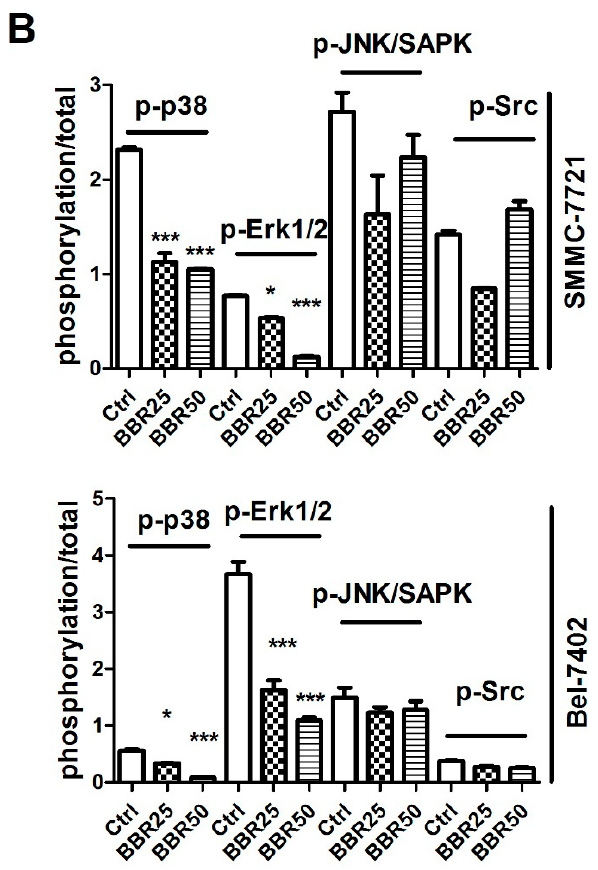
Figure 6. Inactivation of p38 and Erk1/2 in the low concentration of BBR-treated HCC cells by western blot. SMMC-7721 and Bel-7402 cells were treated with BBR for 6 h. Proteins were collected, determined and expression of p-p38, p-Erk1/2, p-JNK/SAPK and p-Src were analyzed by western blot. The expression of total proteins was used as internal standard. ( A ) Protein expression was observed by ChemiDoc™ XRS + Molecular Imager; ( B ) Protein expression was calculated by ImageJ 1.38x software. * p < 0.05 ( vs. the control group); *** p < 0.01( vs. the control group).